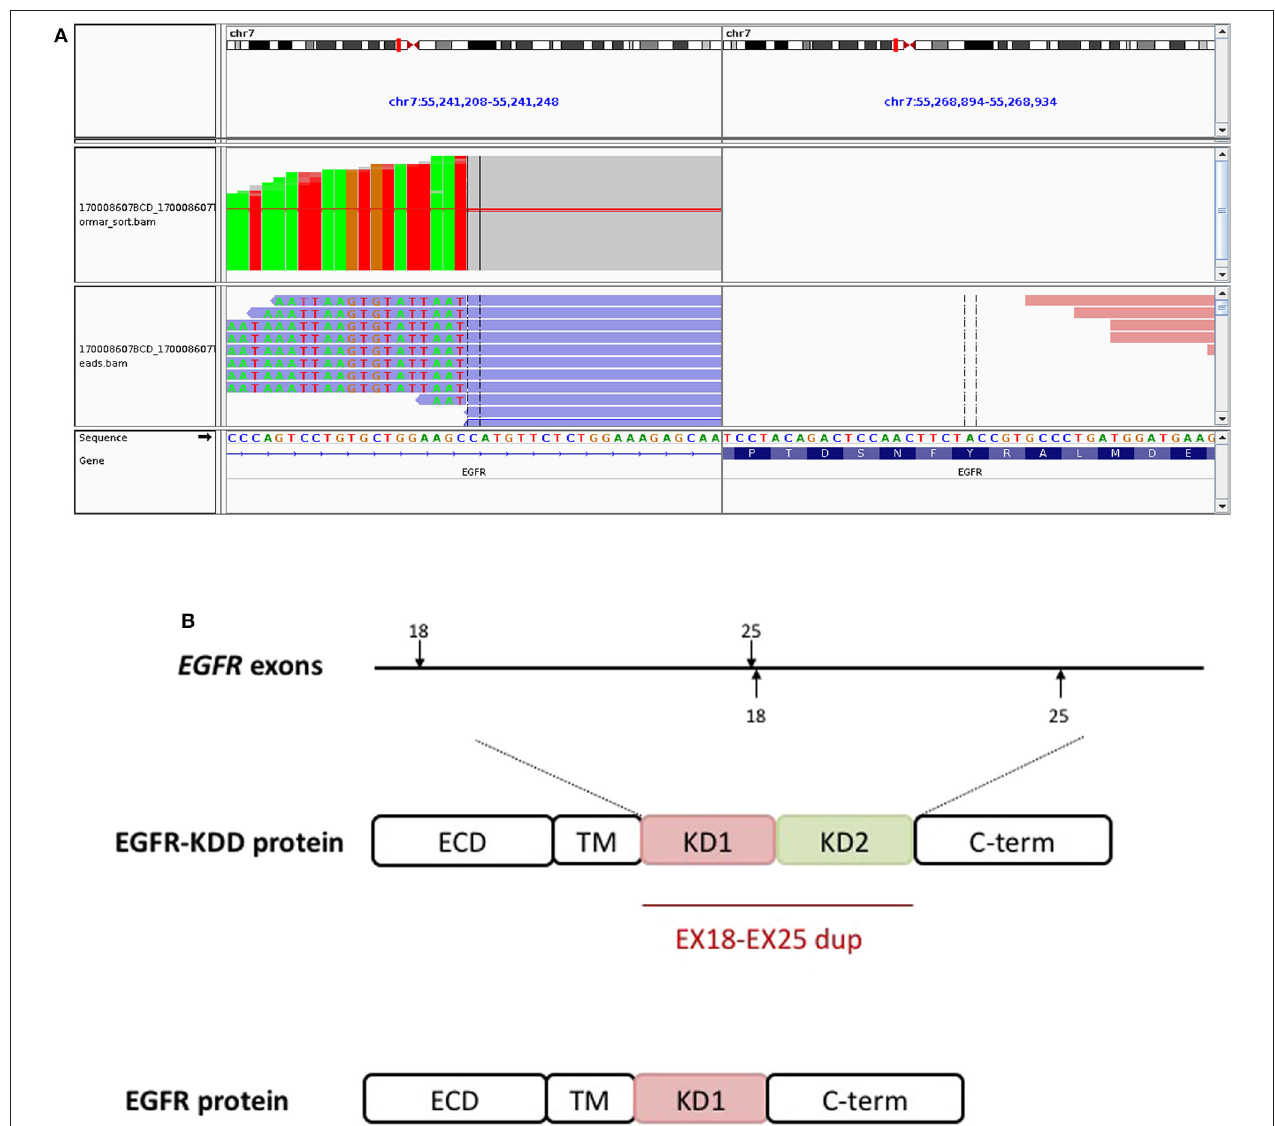
FIGURE 3 | The EGFR -KDD is an oncogenic EGFR alteration. (A) The Integrative Genomics Viewer snapshot of paired NGS reads of tumor and matched blood. (B) Schematic representation of EGFR -KDD depicting the genetic and protein domain structures. ECD, extracellular domain; TM, transmembrane domain; KD1, first kinase domain; KD2, second kinase domain; C-term, carboxyl terminus. Blue, EGFR exons 18–25 #1; orange, EGFR exons 18–25